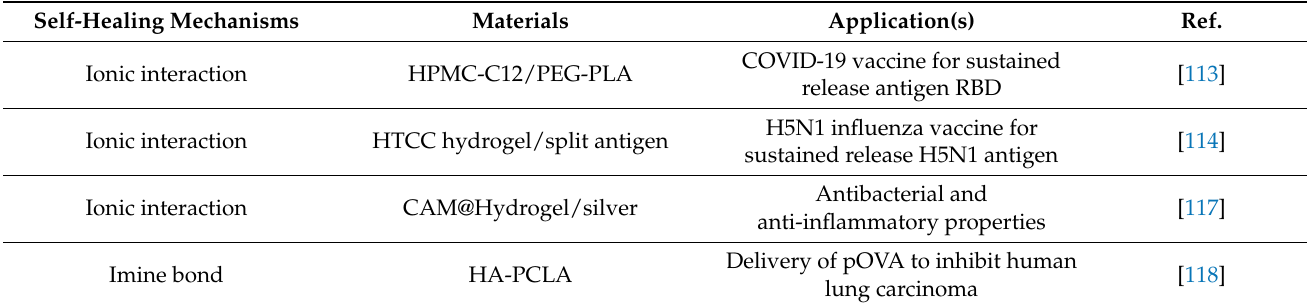
Table 6. A summary of self-healing hydrogels used in vitro and in vivo for lung